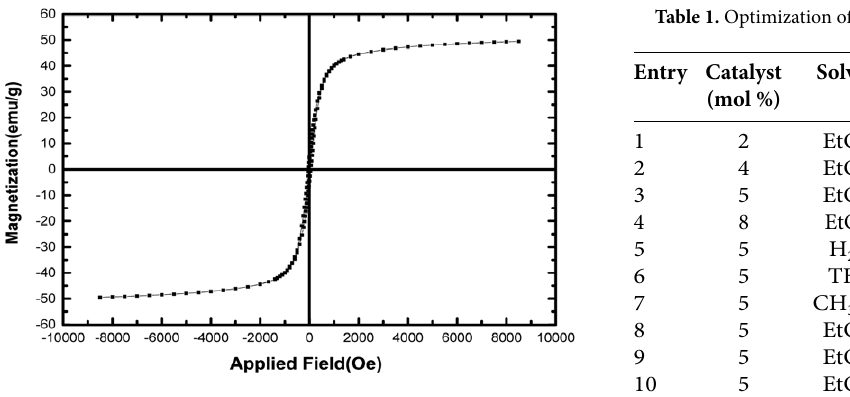
Figure 5. Magnetization curves of the prepared MnFe 2 O 4 nanopar- ticles.